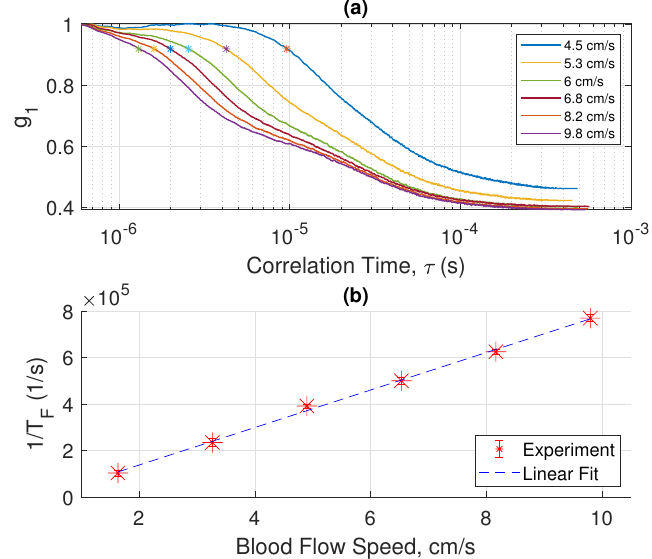
Figure 3. ( a ) Measured E-field correlation function ( g 1 ) versus flow speed of whole blood for a tube diameter of 1.14 mm. ( b ) By taking the inverse of the correlation time at the first inflection point in ( a ), marked using ‘*’, the decorrelation rate (1/ T F ) is plotted versus the flow speed. The scattered data set with error bars represents the 95% confidence interval over 25 measurements, each for a duration of 1 s. The dashed line is a linear fit of the measured data.